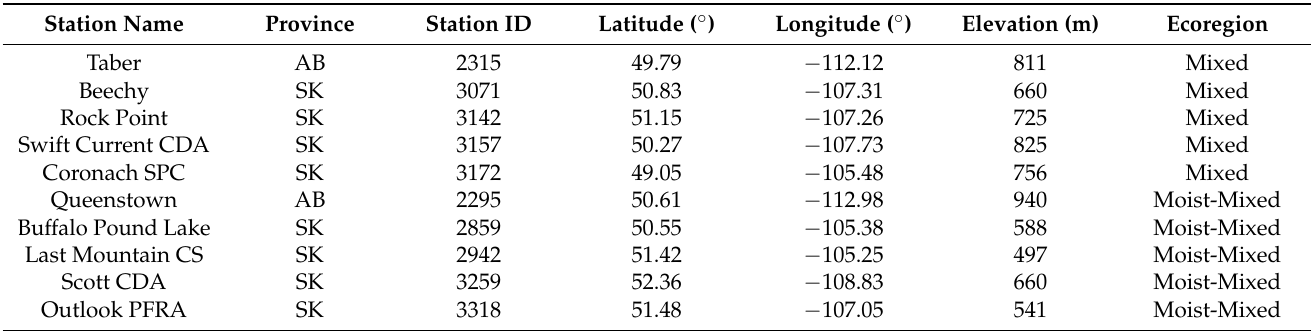
Table 1. Weather stations used to validate ERA5 data with Station ID, Latitude ( ◦ ), Longitude ( ◦ ), Elevation (m), and